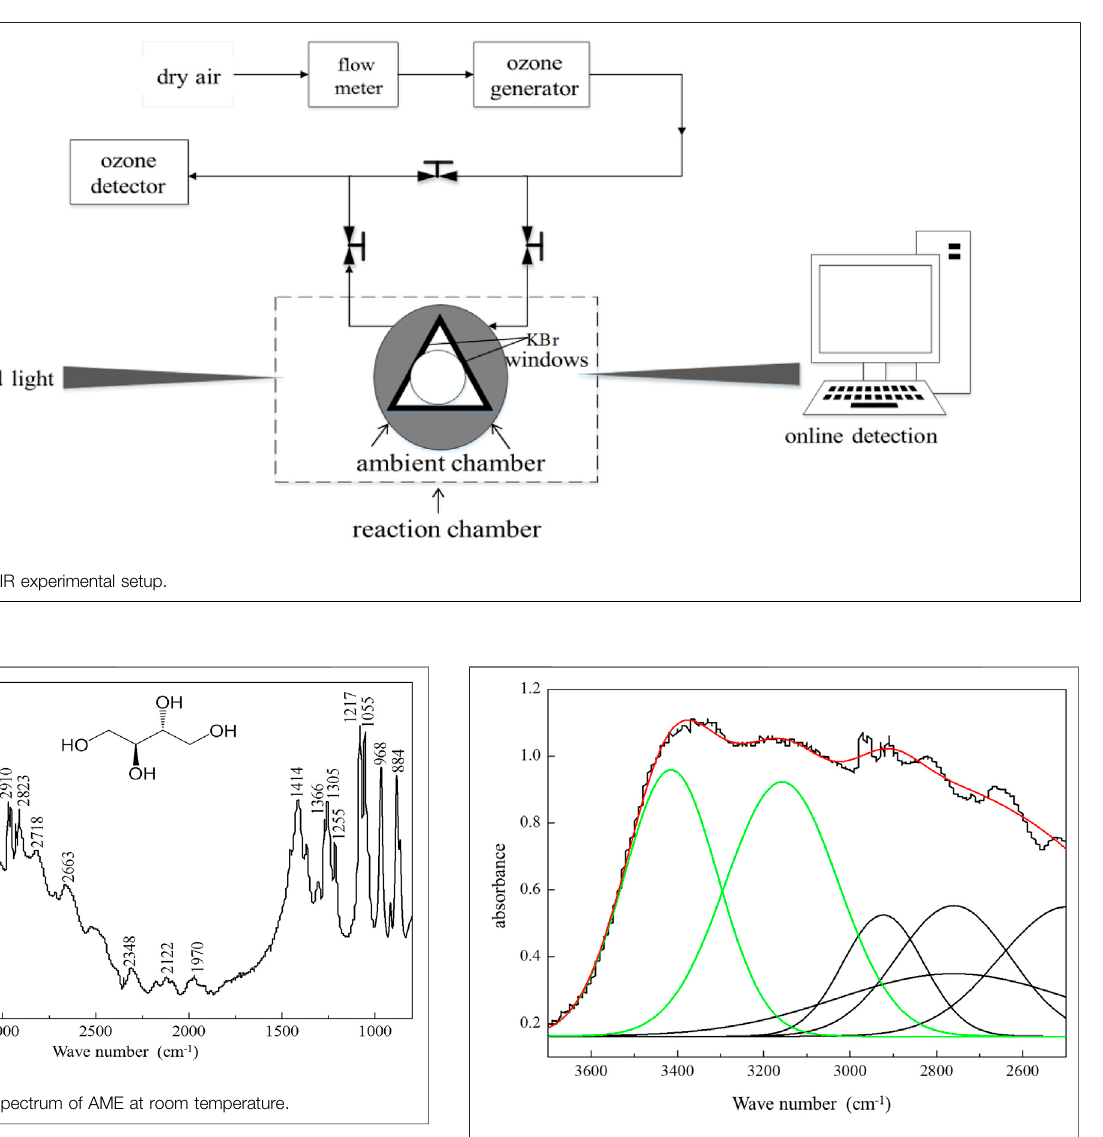
FIGURE3| Gaussian fi ttingresultsofAMEinthe3,700 – 2500cm − 1